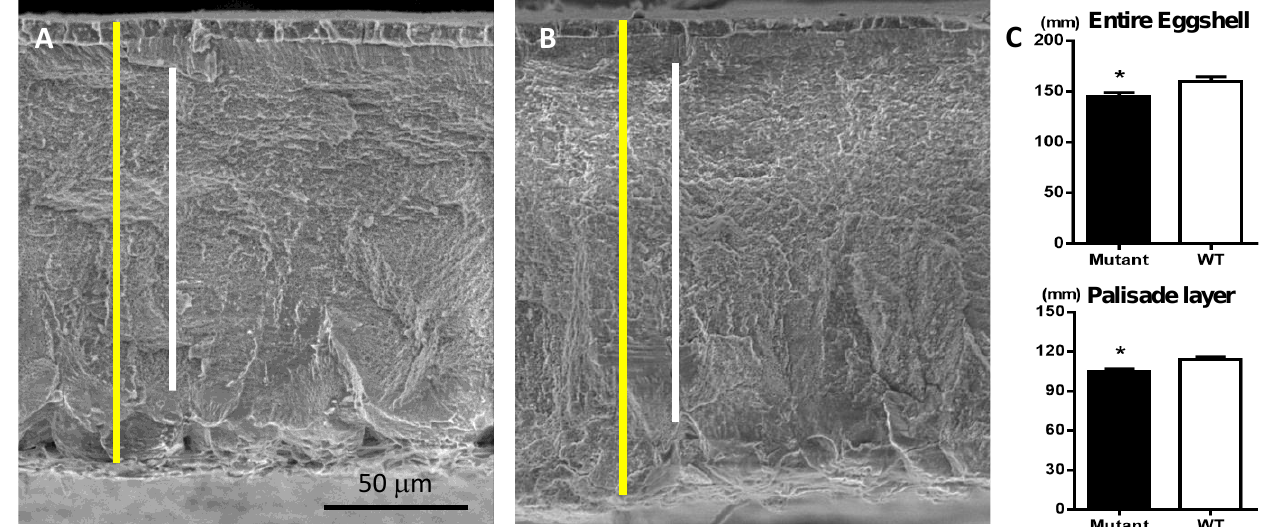
Figure 1. Cross-section of entire eggshell. ( A ) Scanning electron microscopy (SEM) image of MSTN mutant eggshell. ( B ) SEM image of WT eggshell. ( C ) Comparisons of the length of entire eggshell and palisade layer. White bars represent the thickness of eggshell from cuticle layer to mammillary layer; yellow bars represent the thickness of palisade layer; * p < 0.05.